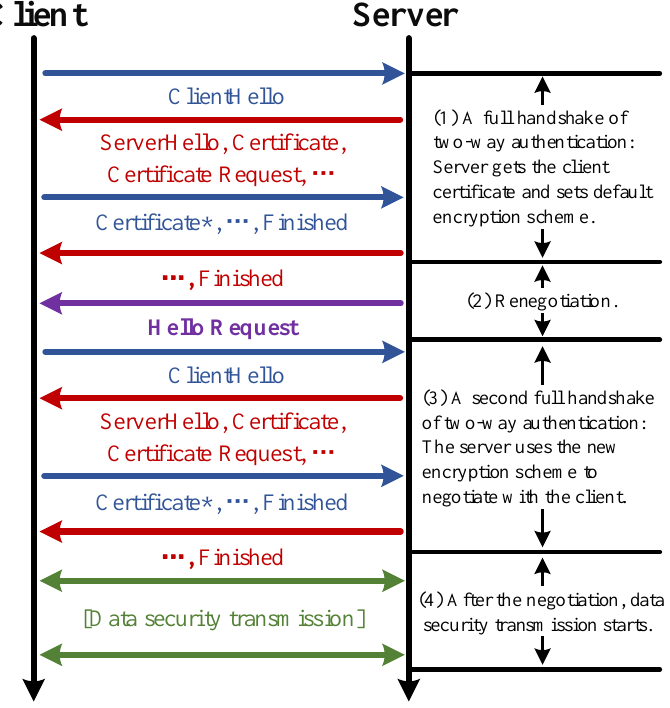
A message sequence diagram of client-aware negotiation based on renegotiation. The messages with ‘*’ are for two-way